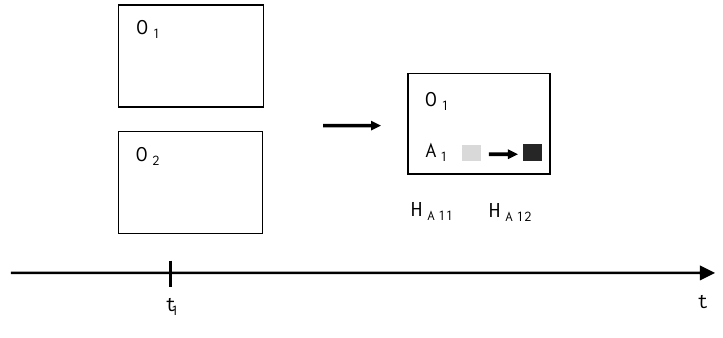
Figure 17. Changes monitoring.